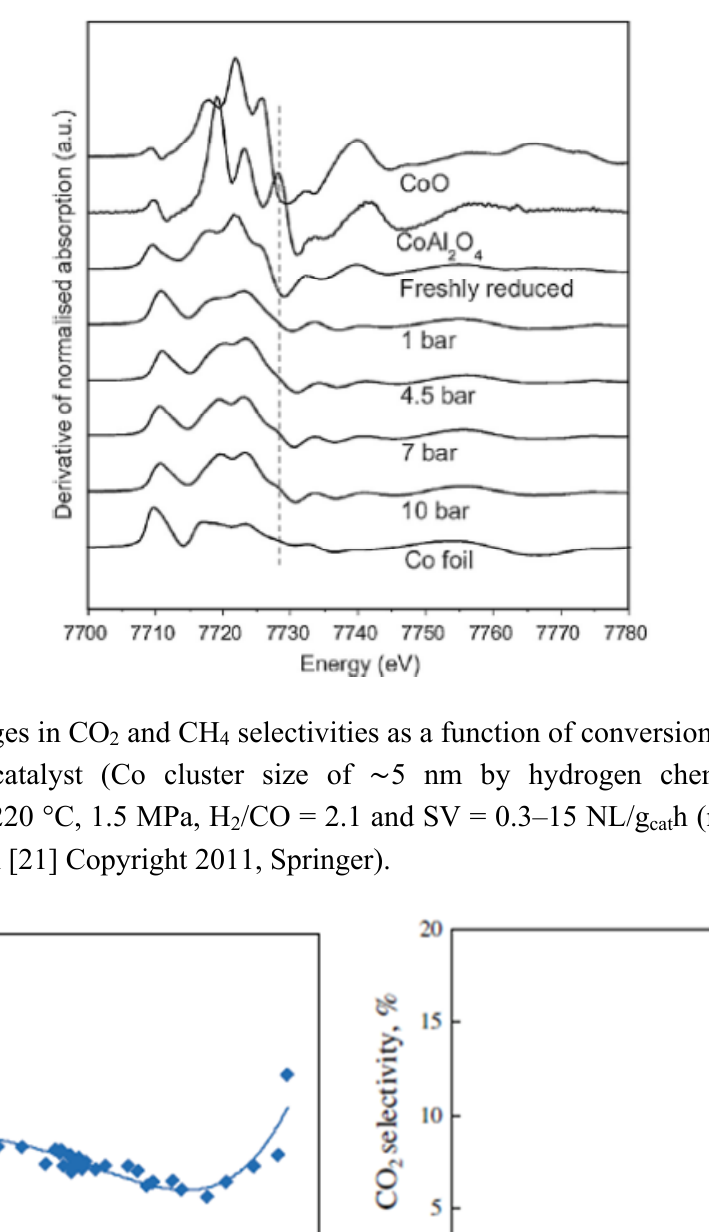
Figure 8. Formation of a minor cobalt aluminate component at 1.0 MPa H conversion in a continuously stirred tank reactor (CSTR) reactor run at 230 °C, 2.0 MPa, 50 vol.% H , 25 vol.% CO and 25 vol.% inerts. Reproduced with permission from [43]. 2 Copyright (2011) Elsevier.